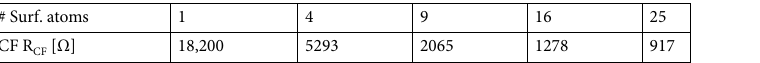
Table 1. Resistance R CF of the Cu nanofilament according to the pyramidal 3D resistor network of 50 layers shown in Fig. 6 as a function of the number of top Cu atoms making contact with the Cu